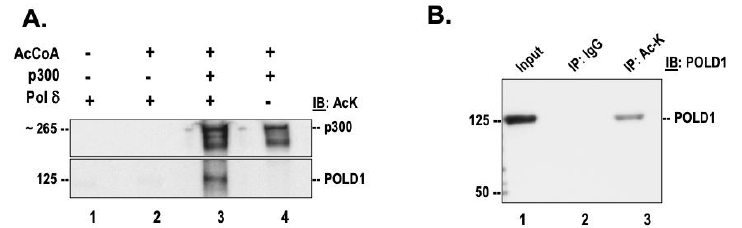
Figure 1. DNA polymerase δ is acetylated in vitro and in vivo. ( A ) Purified recombinant pol δ was incubated in the presence of h-p300 and acetyl CoA and then separated on 4–15% SDS-PAGE, as described in the “Section 2.1”. The acetylated subunits of pol δ (lane 3) were then detected by Western blotting using a pan acetyl lysine (AcK) antibody. ( B ) Whole-cell lysates prepared from HEK293T cells were immunoprecipitated with IgG or AcK antibody. The immunoprecipitated proteins were then separated on 4–15% SDS-PAGE and analyzed by Western blotting using anti POLD1 (p125); 10% of input from the whole-cell lysate (lane 1) served as the control.